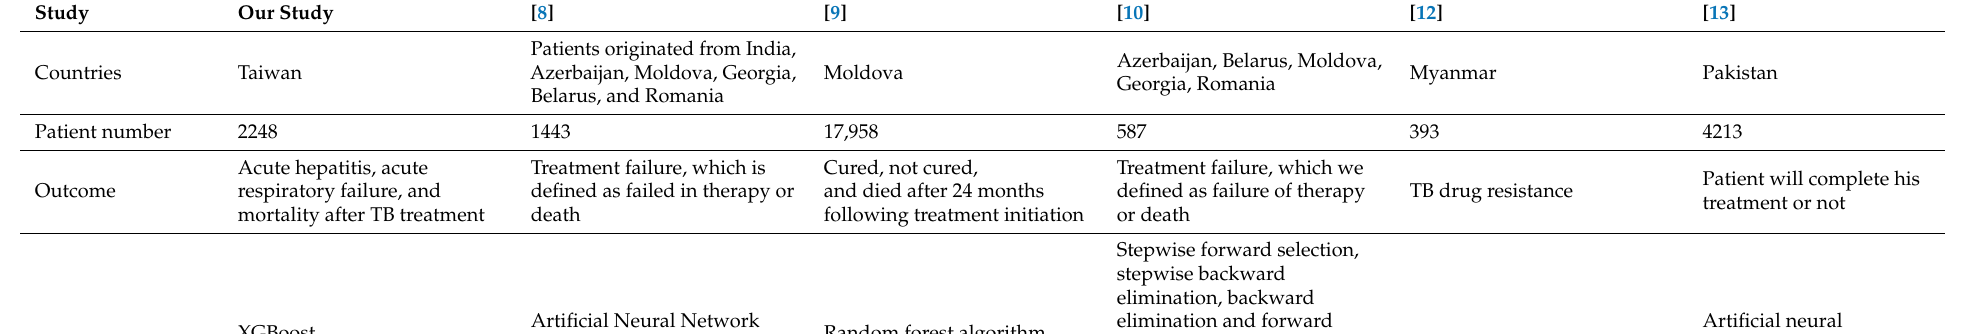
Table 5. A comparison with past related